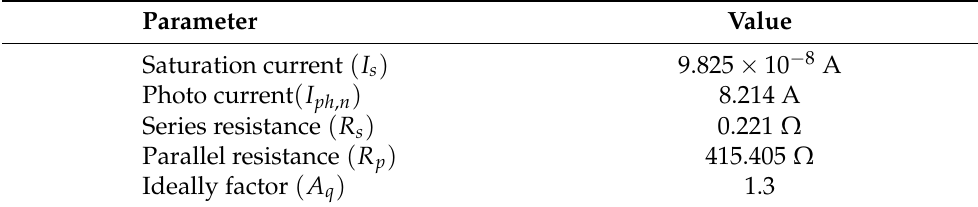
Table 3. Values of the five-parameter model of the KC200GR [49].